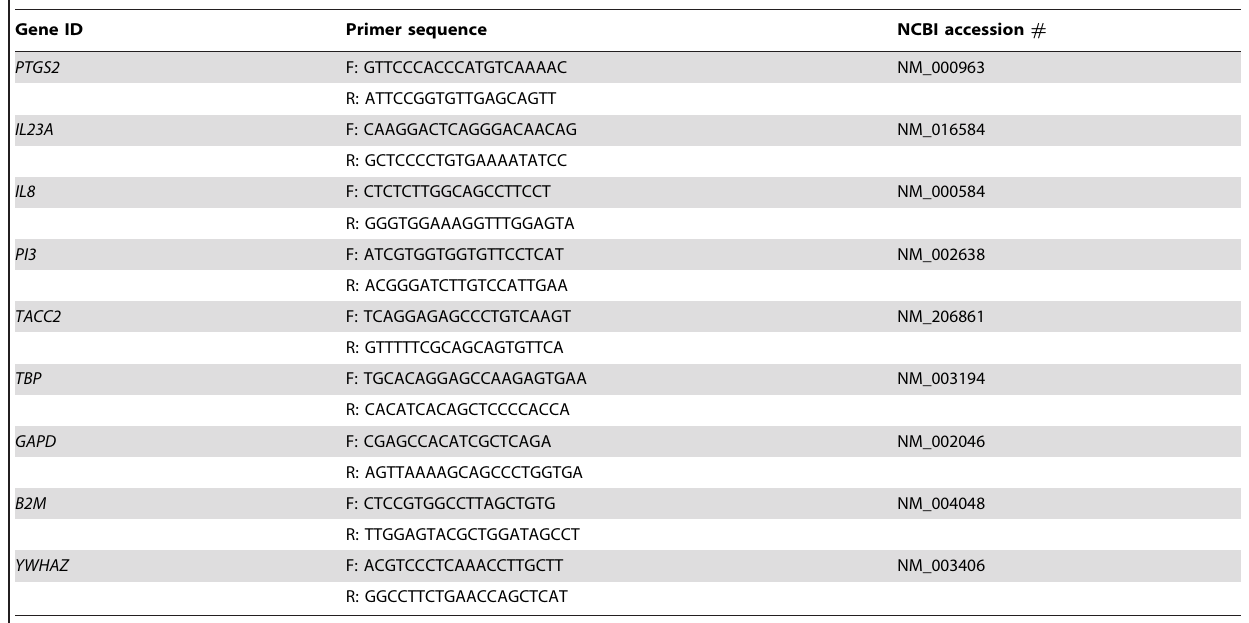
Table 1. List of primers used for RT-qPCR.